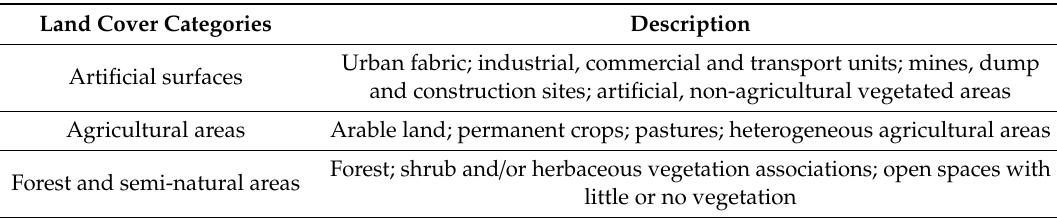
Table 1. Levels of land-cover between 1990 and